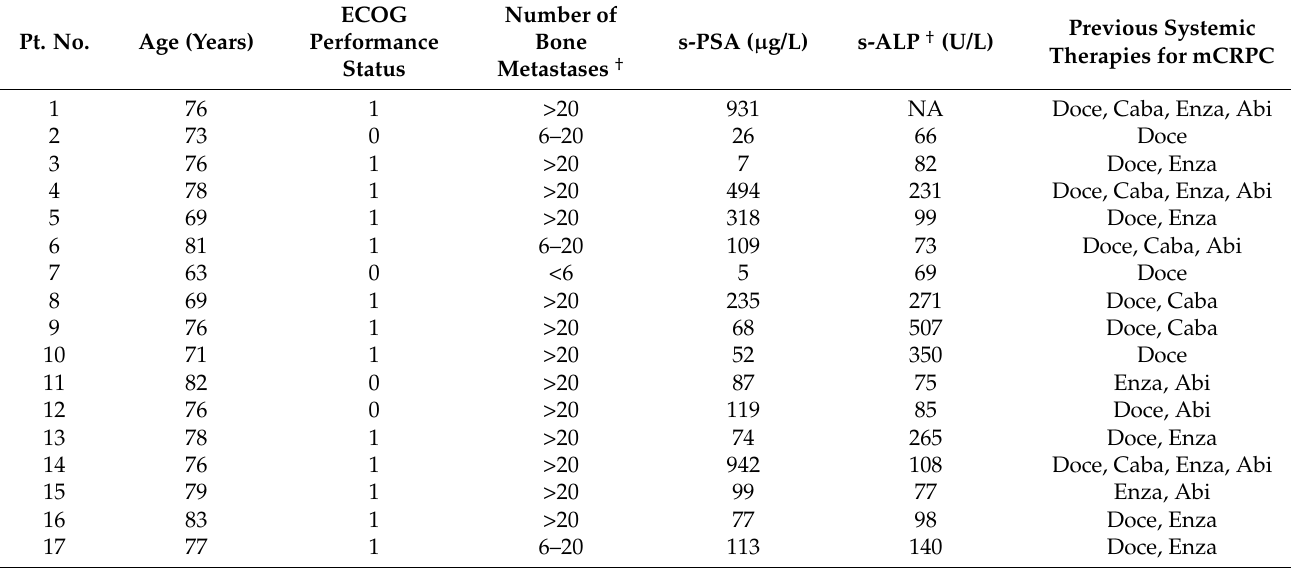
Figure 1. CONSORT diagram of the inclusion process. Table 1. Patient characteristics at initiation of 223 RaCl